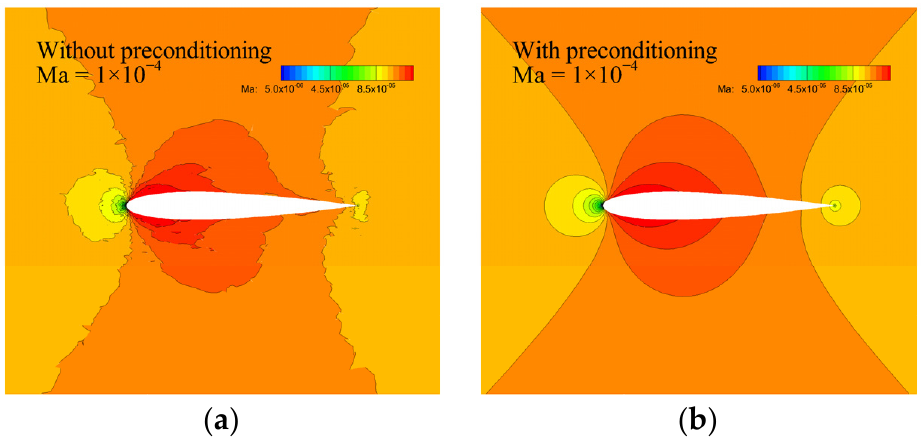
Figure 6. Contours of the Mach number for flows over NACA0012 airfoil. ( a ) Without preconditioning; ( b ) with preconditioning.